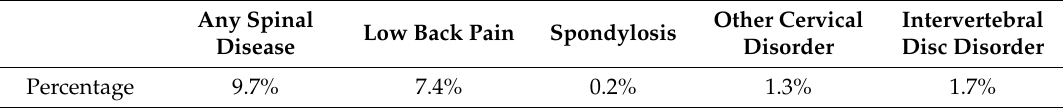
Table 2. Percentage of Spinal Diseases in the Analysis Sample (N = 23,048).